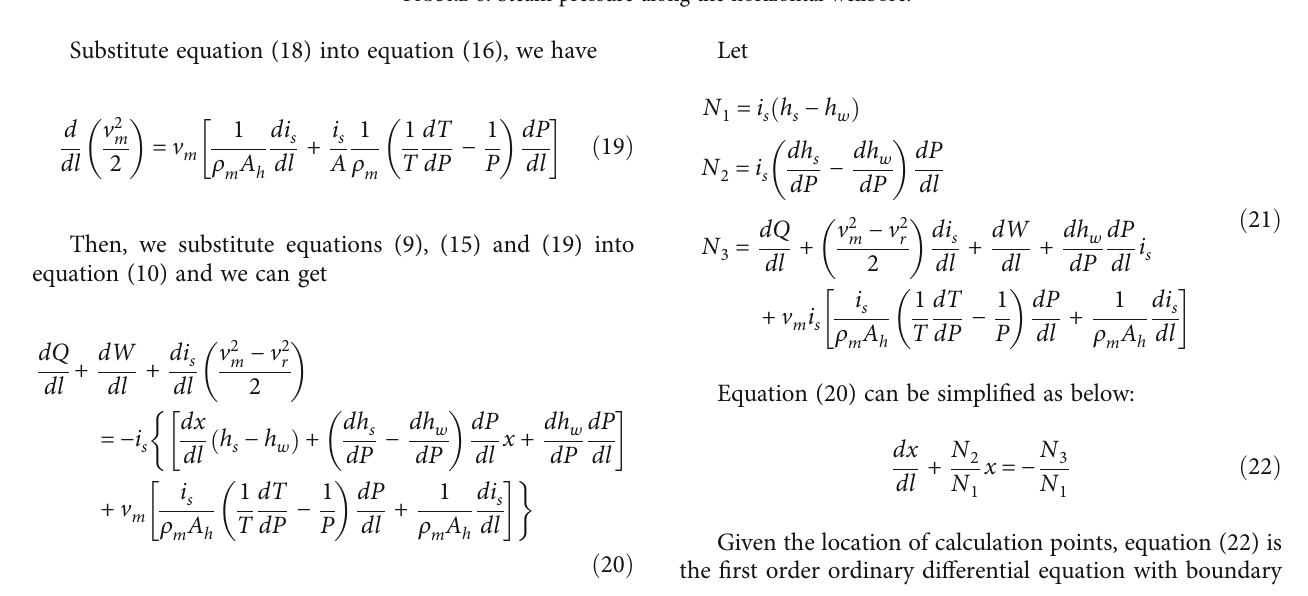
Figure 6: Steam pressure along the horizontal